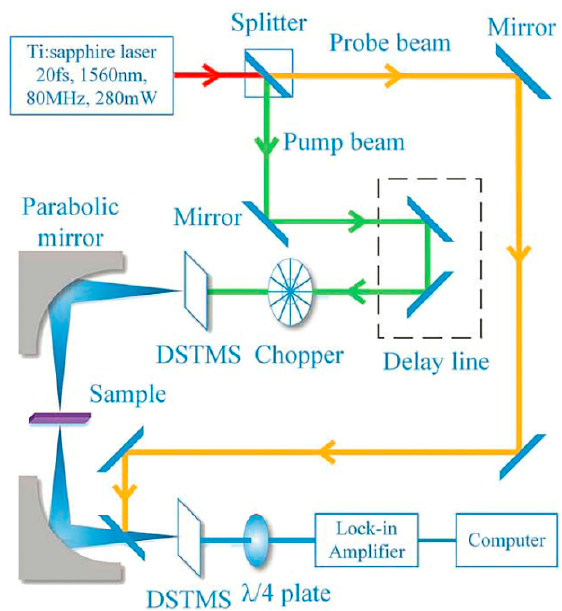
Figure 3. Schematic diagram of the transmission THz-TDS system. Adapted from [60], with permission from © 2016 Taylor & Francis.